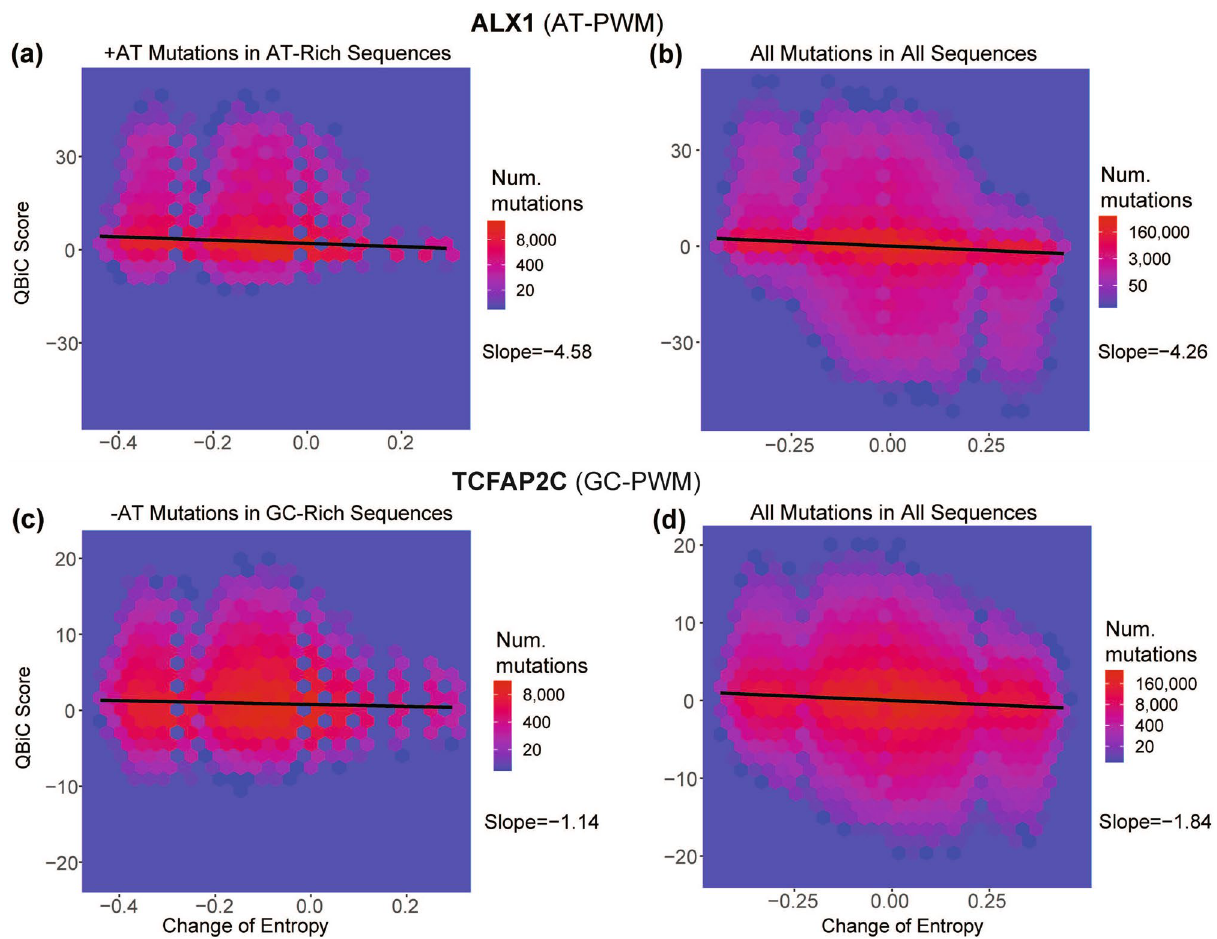
Figure 4. Relationships between change in QBiC-score and change in entropy due to + AT mutations or − AT mutations in TFs with an AT-PWM or a GC-PWM. ( a ) ALX1 has an AT-PWM (72% average AT content in the PWM). For ALX1, + AT mutations in AT-rich sequences tend to decrease entropy (median − 0.11, MAD 0.09) and have positive QBiC-scores (median 1.53, MAD 1.88). Larger decreases in entropy are weakly associated with higher QBiC scores (slopes as shown). ( b ) By contrast, over all mutations in all sequences the median change in entropy and the median QBiC score are 0 (MAD of QBiC score 0.10, MAD of entropy 1.36, one-sided Wilcoxon rank-sum test versus + AT mutations in AT-rich sequences p < 2.2 × 10 −16 ). Larger decreases in entropy are still weakly associated with higher QBiC scores. ( c ) TCFAP2C has a GC-PWM (32% average AT content in the PWM). For TCFAP2C, − AT mutations in GC-rich sequences tend to decrease entropy (median − 0.11, MAD 0.09) and have positive QBiC scores (median 0.47, MAD 2.28). Larger decreases in entropy are weakly associated with higher QBiC-scores. ( d ) By contrast, over all mutations in all sequences the median change in entropy and the median QBiC score are 0 (MAD of QBiC score 0.10, MAD of entropy 1.50, one-sided Wilcoxon rank-sum test versus − AT mutations in GC-rich sequences p < 2.2 × 10 −16 ). Larger decreases in entropy are still weakly associated with higher QBiC scores. Change of entropy calculated by the “entropy” function in the DescTools package (https ://CRAN.R-proje ct.org/packa ge=DescT ools); slopes computed by the rlm function in the MASS package, https ://CRAN.R-proje ct.org/packa ge=MASS). Num. mutations indicates the number of mutations in 11-mer context in each hexagonal bin. AT-rich sequences are > 60% AT; GC-rich sequences are < 40%